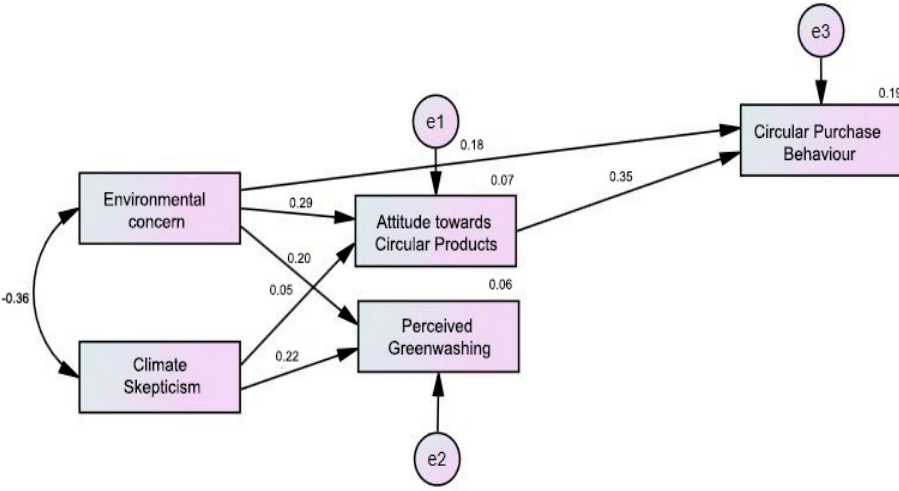
Figure 1. Path model with standardised parameter estimates (e1, e2, e3 = unobserved errors).